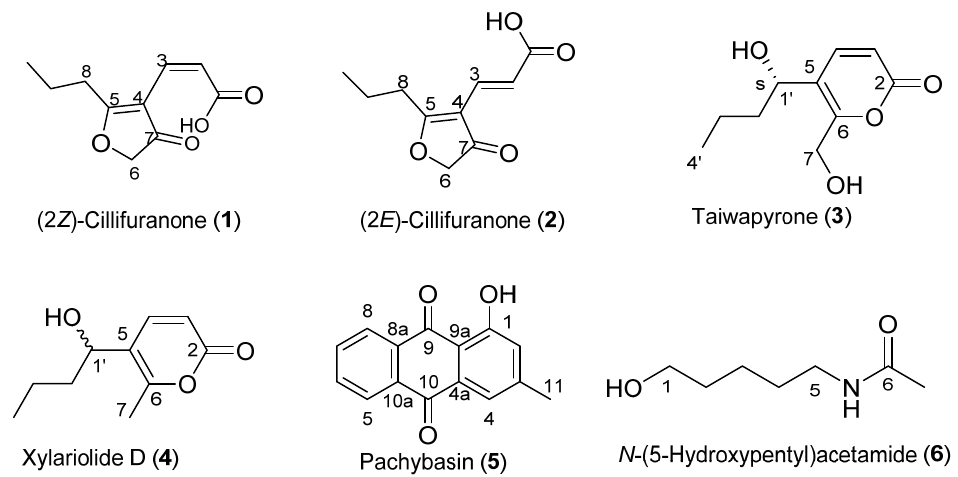
Figure 1. Structures of isolated natural products 1 – 6 .